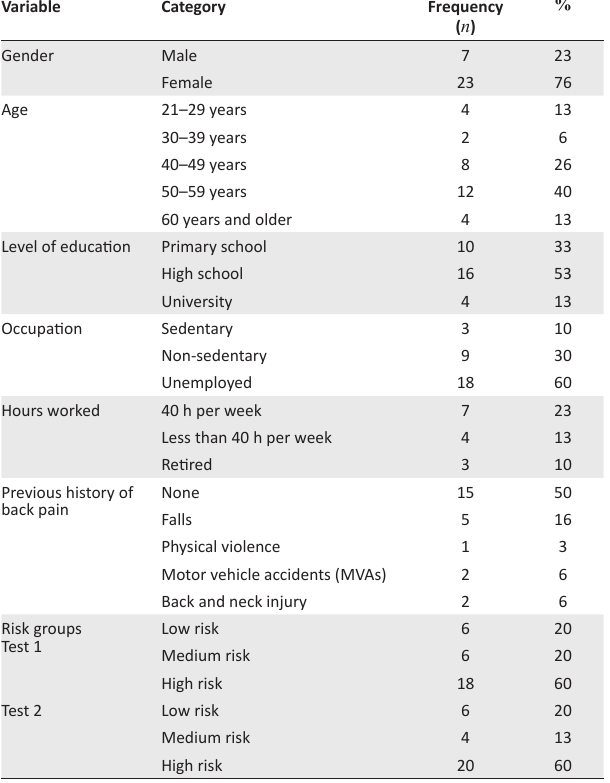
TABLE 1: Demographic characteristics ( n = 30).